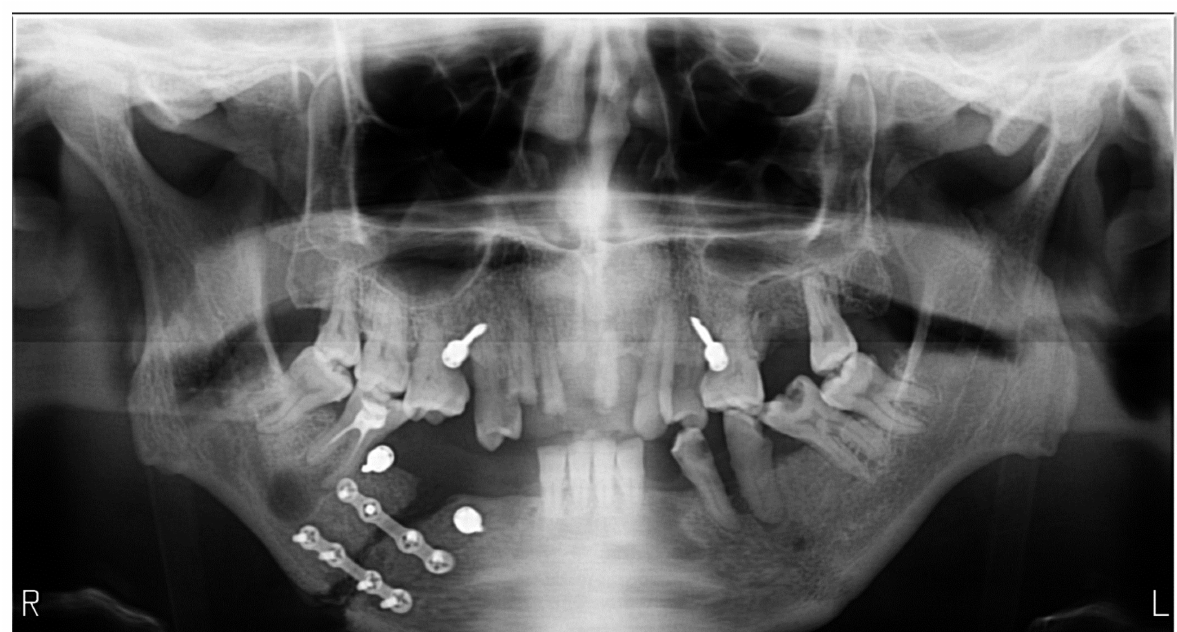
Figure 2. Orthopantomography of a case with a double fracture of the mandible, left subcondylar, and lateral on the right side, the later surgically reduced and fixed, exemplifies the head in flexion error, with poor visibility in the menton region.